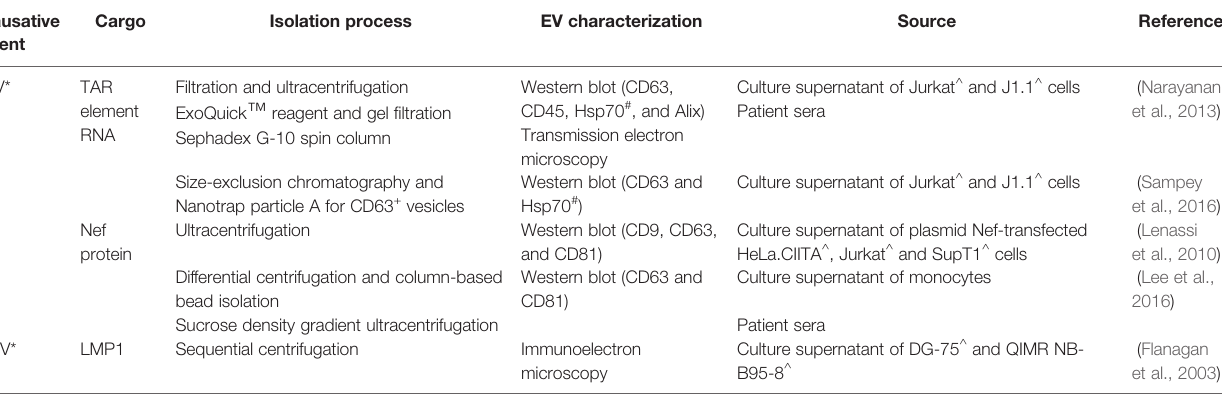
TABLE 1 | Types of viral elements present in extracellular vesicles (EVs) released from cells infected by HIV or Epstein-Barr virus (EBV). Causative